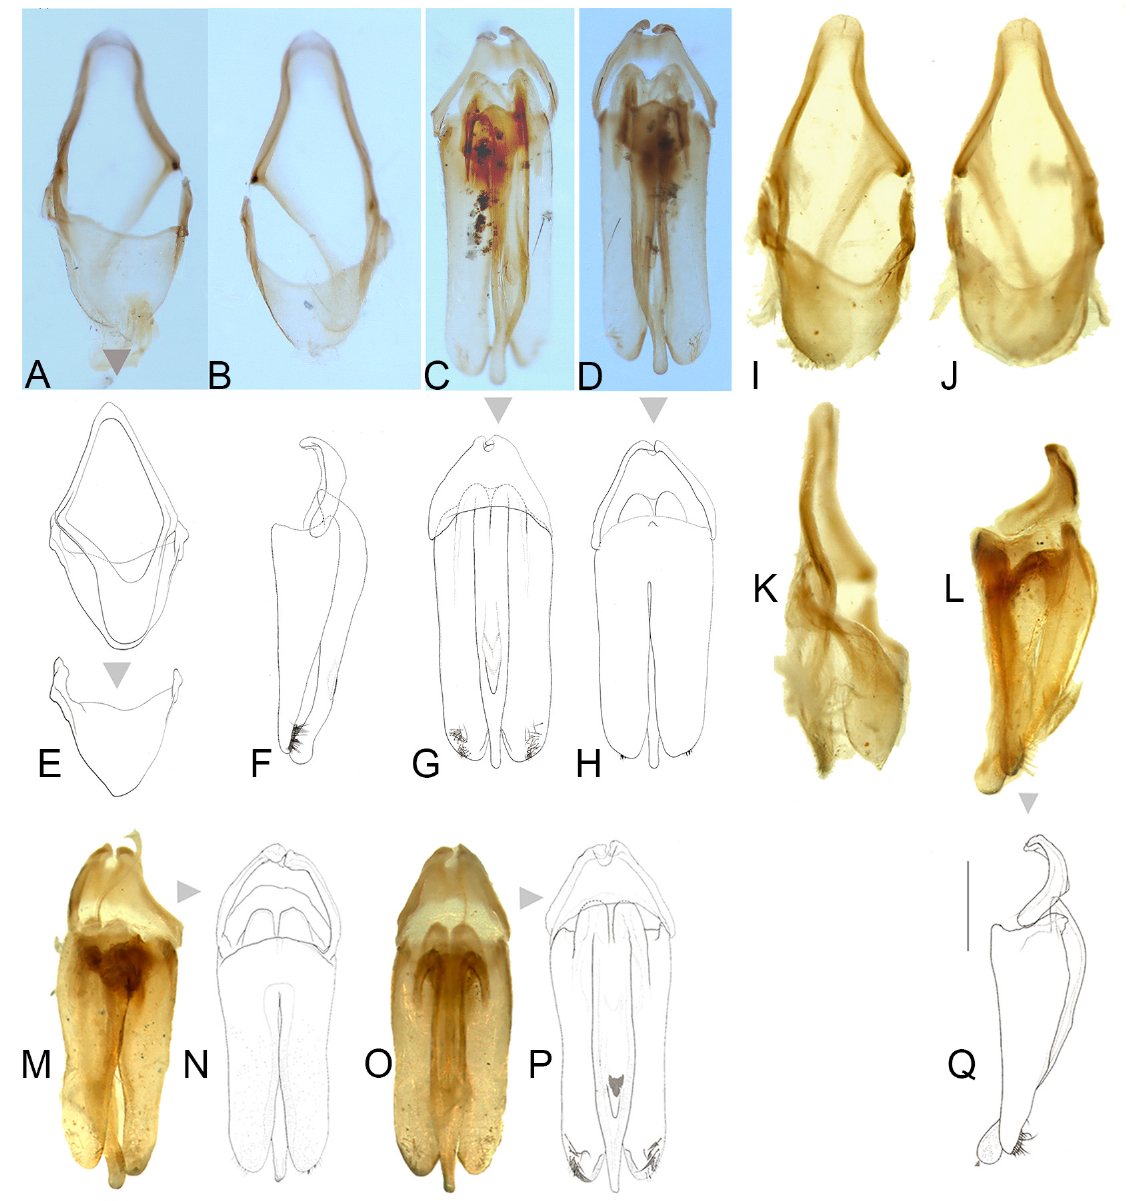
Fig. 5. Features of male genitalia. A‒H . Nipponoluciola cruciata (Motschulsky, 1854) gen. et comb. nov. I‒Q . Nipponoluciola owadai (Satô & Kimura, 1994) gen. et comb. nov. A–B, E, I‒K . Aedeagal sheath: dorsal (A, lower portion of E shows tergite alone; I), ventral (B, upper portion of E; J), and left lateral (K) views. C–D, F–H, L‒Q . Aedeagus: ventral (C, G, O, P), dorsal (D, H, M, N), and right lateral (F, L, Q) views. Images by L. Ballantyne (A‒D, I–M, O) and I. Kawashima (E‒H, N,